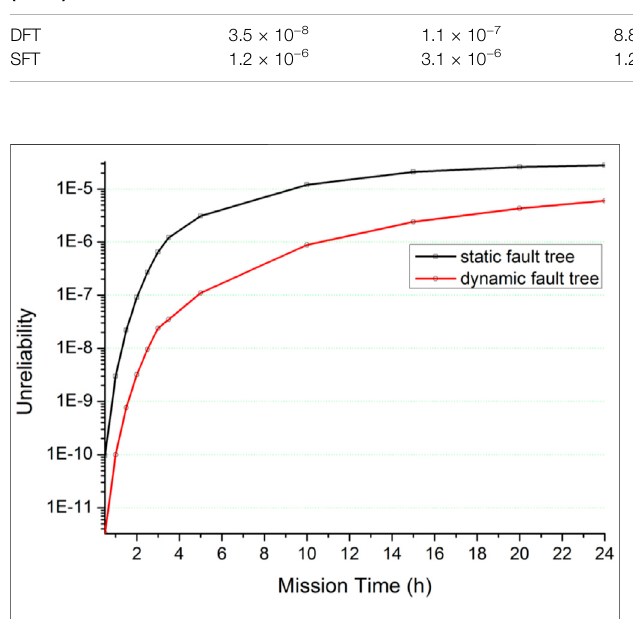
FIGURE 8 | Unreliability of the DGS in the mission time of 24